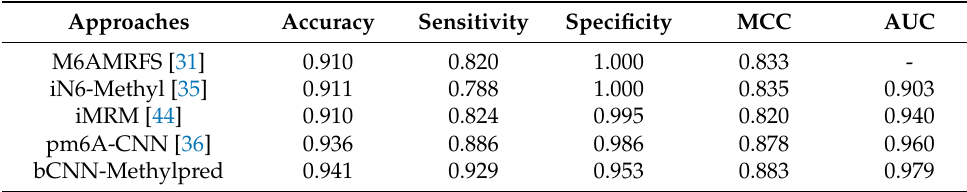
Table 7. Comparison of m6A site prediction using proposed and state-of-the-art approaches based on H. sapiens species.